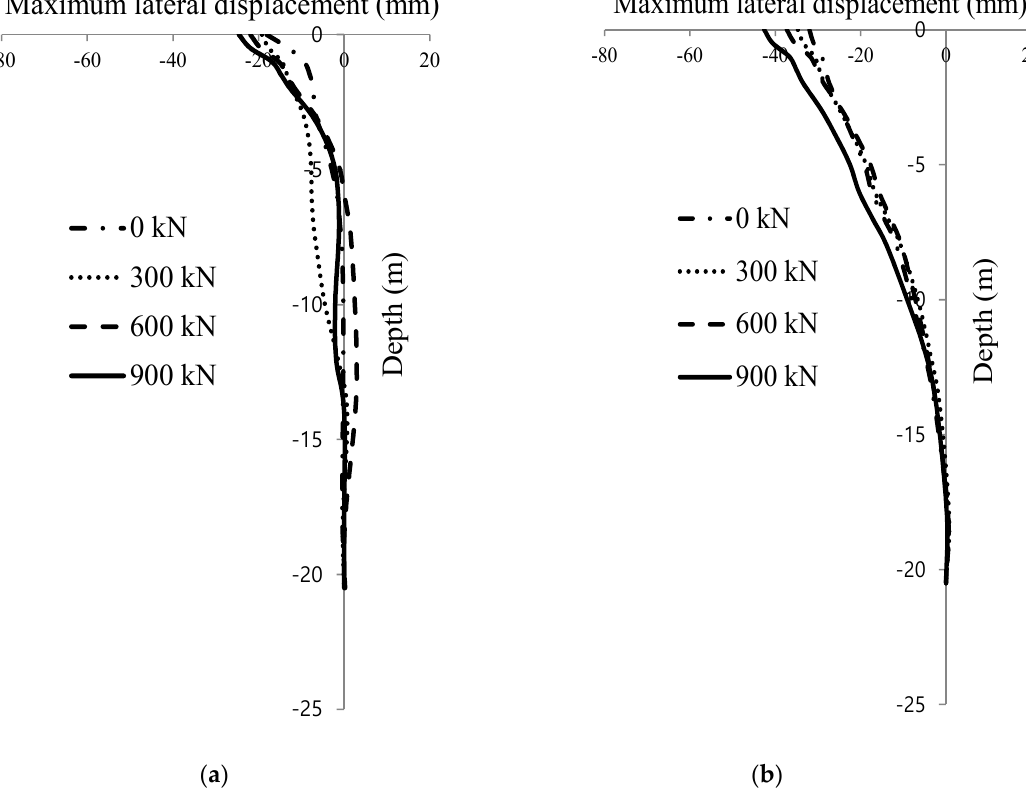
Figure 16. Dynamic pile response envelopes according to the weight of superstructure in liquefiable condition: ( a ) Input acceleration: 0.13 g, ( b ) Input acceleration: 0.25 g.